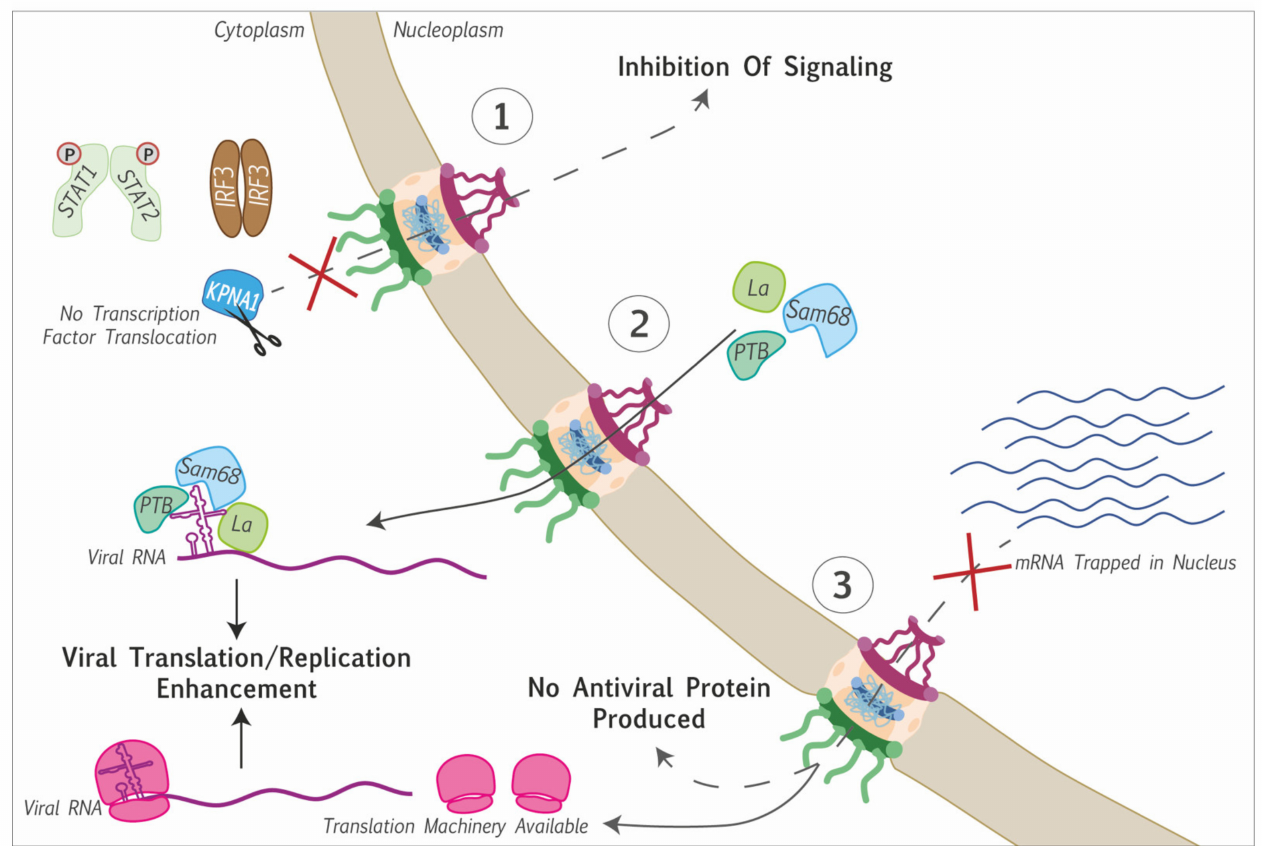
Figure 3. Consequences of protein and RNA trafficking perturbation induced by Picornaviruses. (1) Cytoplasmic retention of transcription factors (STAT1/2, IRF3) thereby inhibiting transcriptional induction of cellular genes: e.g., karyopherin subunit α 1 cleavage prevents the translocation of STAT1/2 into the nucleus. (2) Nuclear proteins are delocalized to the cytoplasm, where they interact with the viral genome to promote viral genome translation or replication. (3) Blocking of mRNA export, preventing the translation of antiviral proteins, and making the translation machinery available for viral mRNA